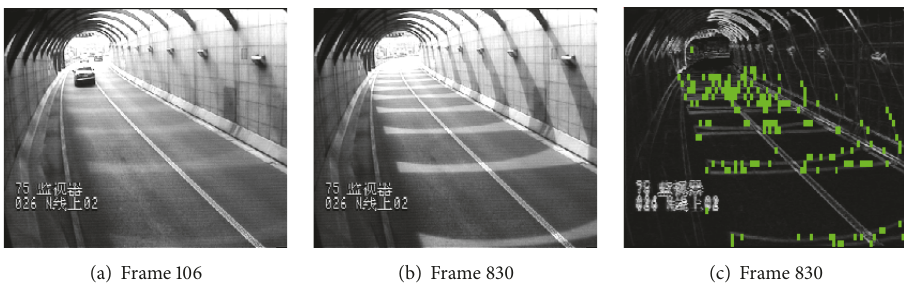
Figure 12: Shanghai Fuxing Road Tunnel